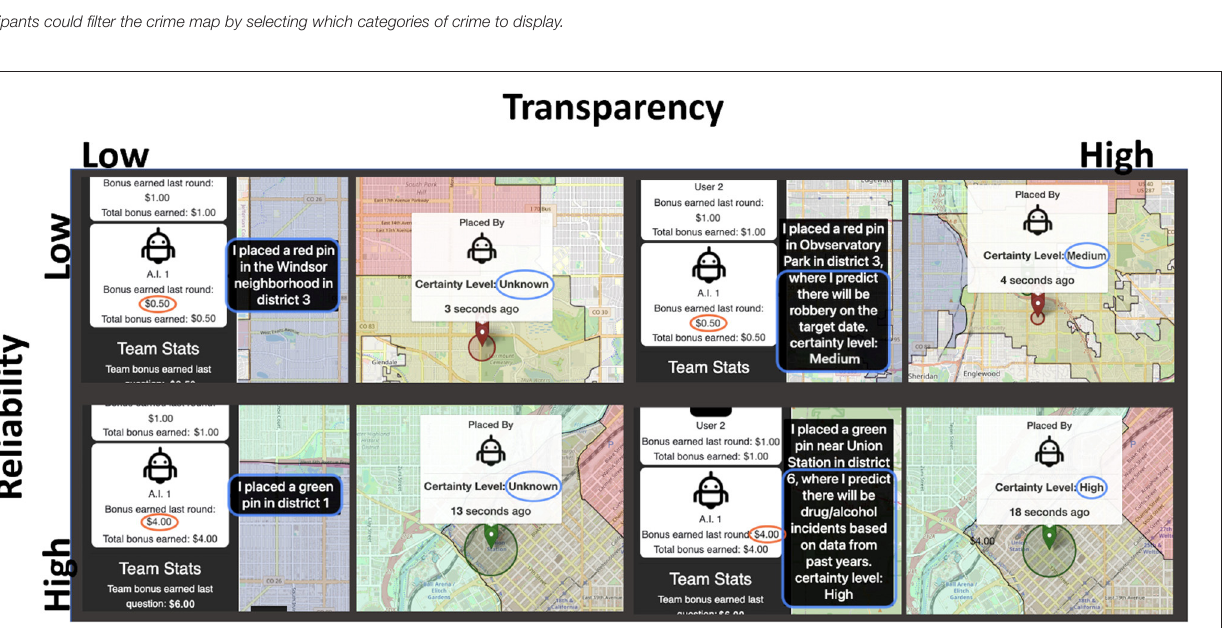
FIGURE 2 | Example of transparency (high/low) and reliability (high/low) manipulations in